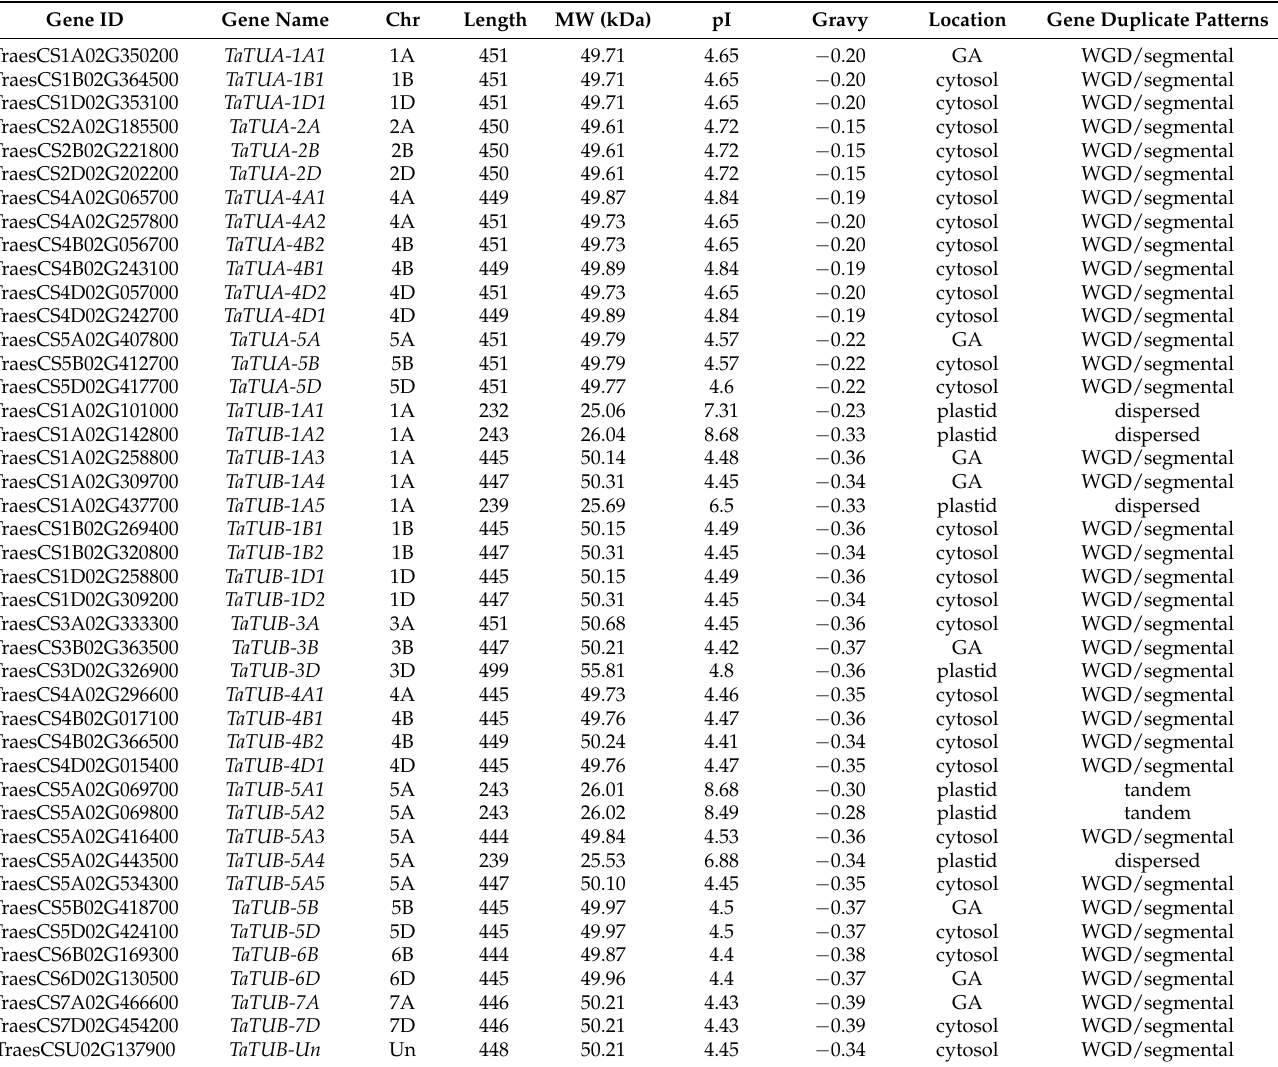
Table 1. Identification of TaTUA and TaTUB genes, physicochemical characteristics and subcellular localization of TaTUA and TaTUB proteins, and gene duplication